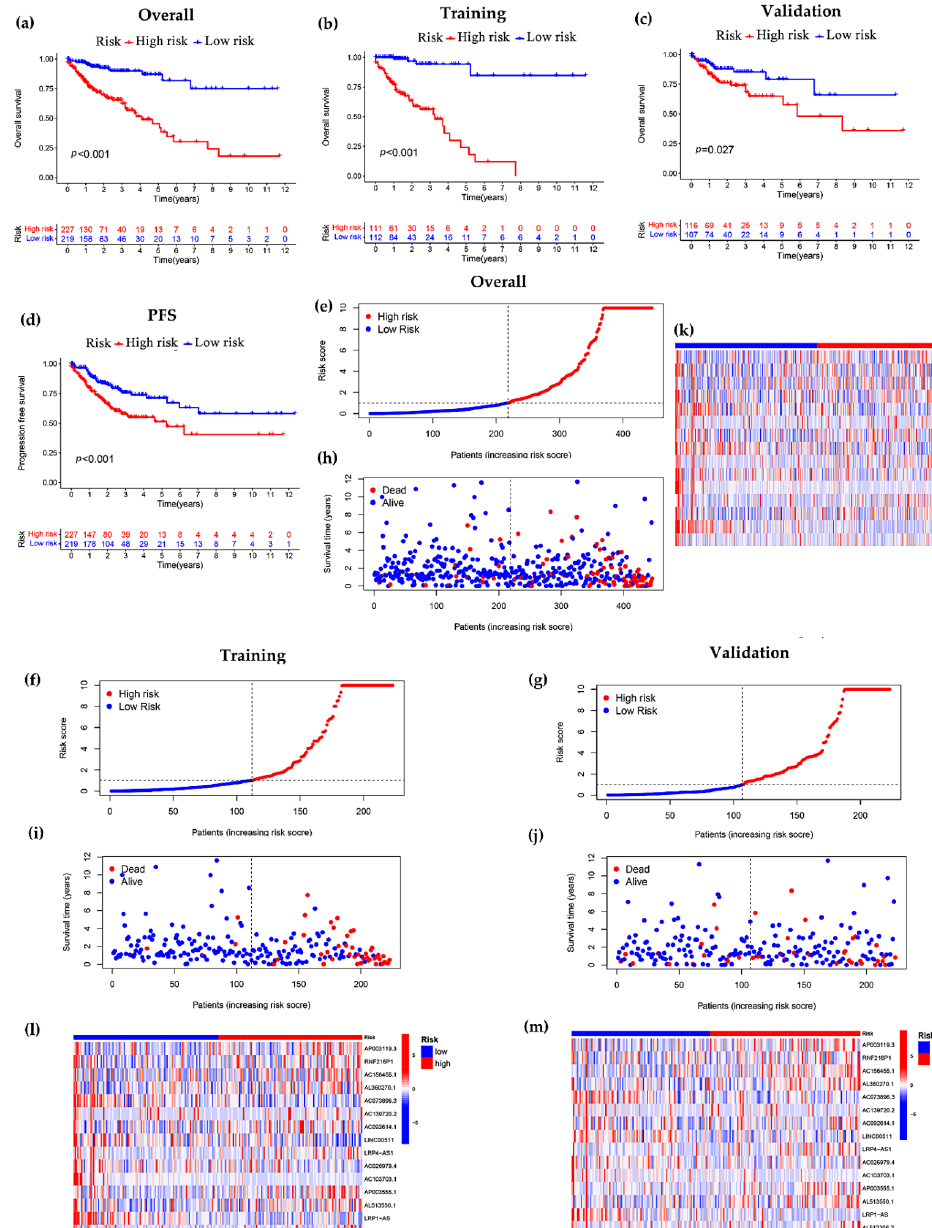
Figure 3. Construction of signature models for cuproptosis-related lncRNA in the overall group, training group and validation group. ( a – c ) Analysis of overall survival between high- and low-risk subgroups in overall, training and validation groups (compared to low-risk subgroup, high-risk subgroup showed significantly unfavorable prognosis, p < 0.05). ( d ) Exploration of differences in progression-free survival between high- and low-risk subgroups based on the overall subgroup (patients in the low-risk had significantly better PFS than high-risk patients, p < 0.001). ( e – g ) Risk score distribution (red is risk score of high-risk patients, blue is risk score of low-risk patients). ( h – j ) Relationship between risk score and survival time (horizontal coordinates indicate patients’ risk score, vertical coordinates indicate patients’ survival time. The number of patients who died increased with increasing risk score). ( k – m ) Heatmap of the expression of 15 lncRNAs in the high- and low-risk